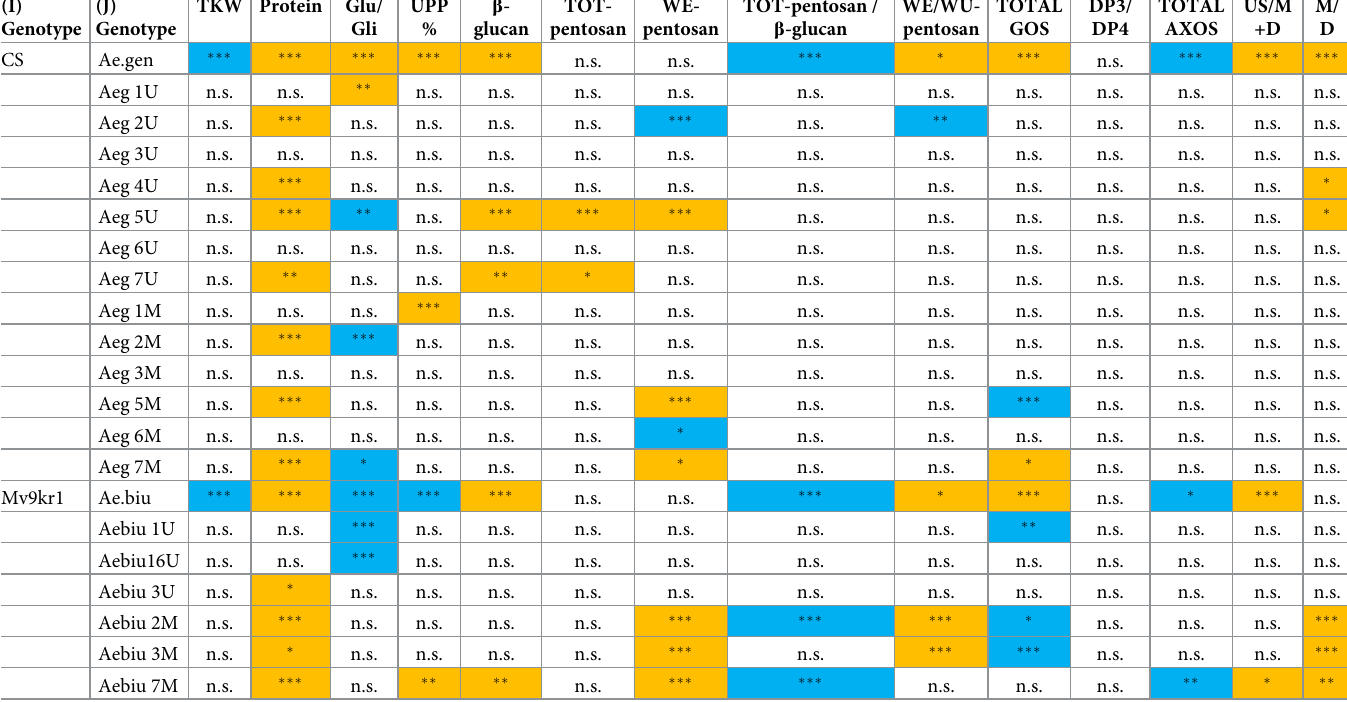
Table 5. Comparison of the effects of different chromosomes in a wheat ( T . aestivum ) genetic background under well-watered conditions using the Post Hoc multi- ple pairwise comparison test. Orange and blue blocks indicate values higher and lower than the control, respectively. (I) (J) TKW Protein Glu/ Genotype Genotype